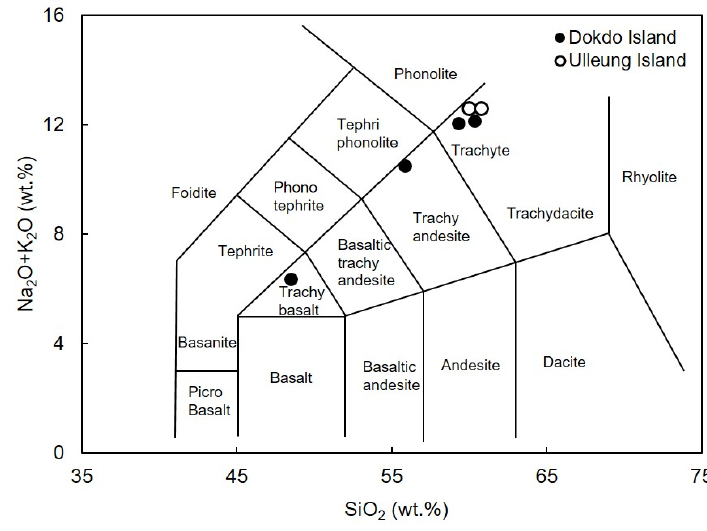
Figure 4. Total alkali–silica (TAS) diagram [49] of DUI volcanic rocks. Table 1. Chemical compositions of trachytes from Dokdo and Ulleung islands. Location Dokdo Island Ulleung